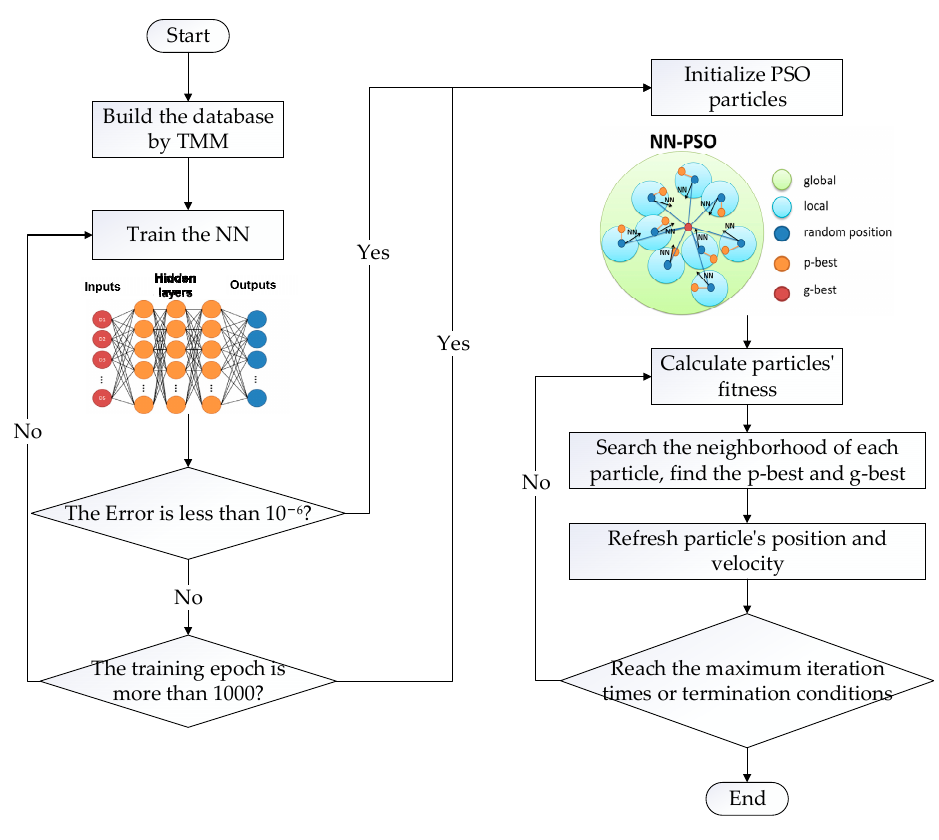
Figure 1. The flow chart of NN-PSO.